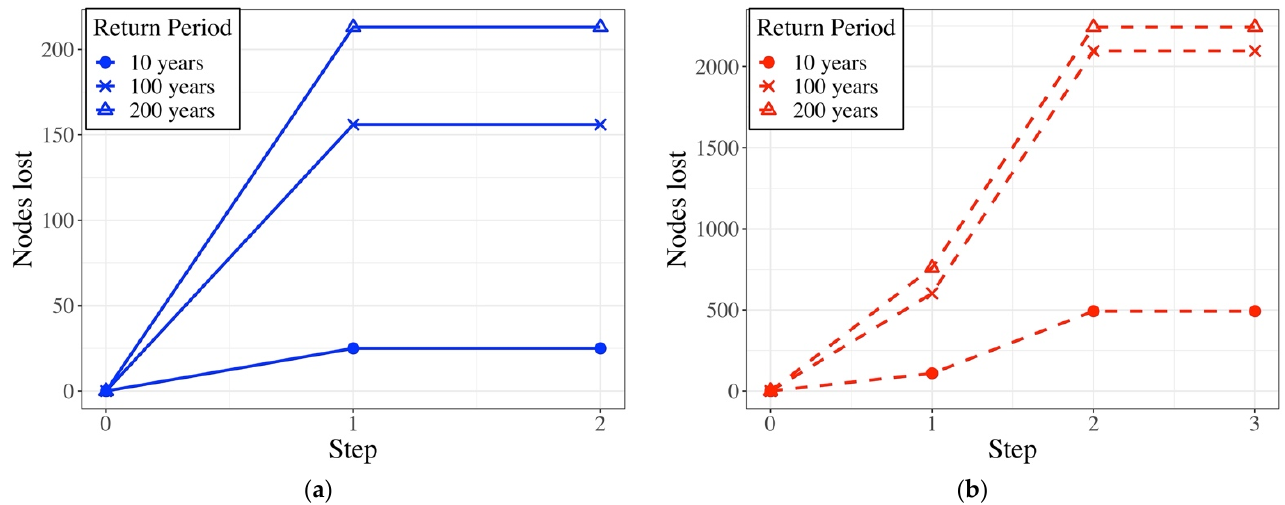
Figure 9. Impact propagations for different return periods: ( a ) fluvial scenarios and ( b ) pluvial scenarios.